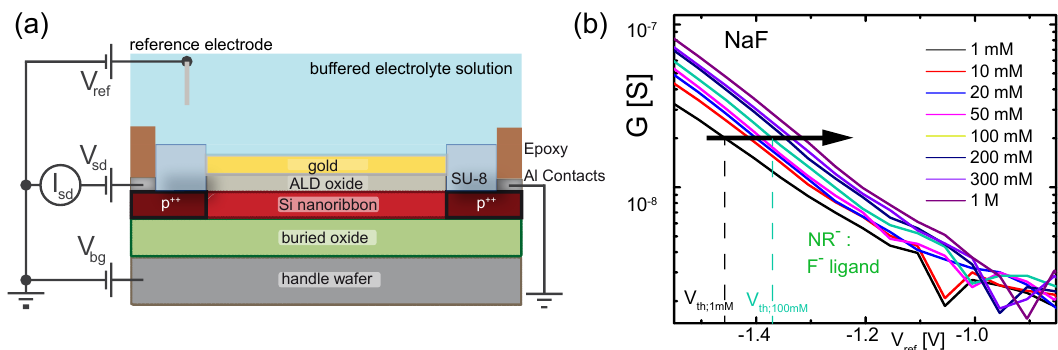
Figure 2. ( a ) measurement setup and device cross section. The working point of the transistor can be controlled by the liquid gate potential V ref applied to the reference electrode or by the backgate voltage V bg applied to the handle wafer. A constant source-drain voltage V sd = 100mV is applied and the current through the channel I sd is measured; ( b ) conductance G versus liquid gate potential V ref of a 1 µ m-wide nanoribbon functionalized with F − ligands measured in buffered solutions with increasing NaF concentrations. The curves shift to the right with increasing concentration indicating adsorption of negatively charged species at the surface. The threshold voltage is determined as the value of V ref at a constant conductance value in the subthreshold as indicated by the black